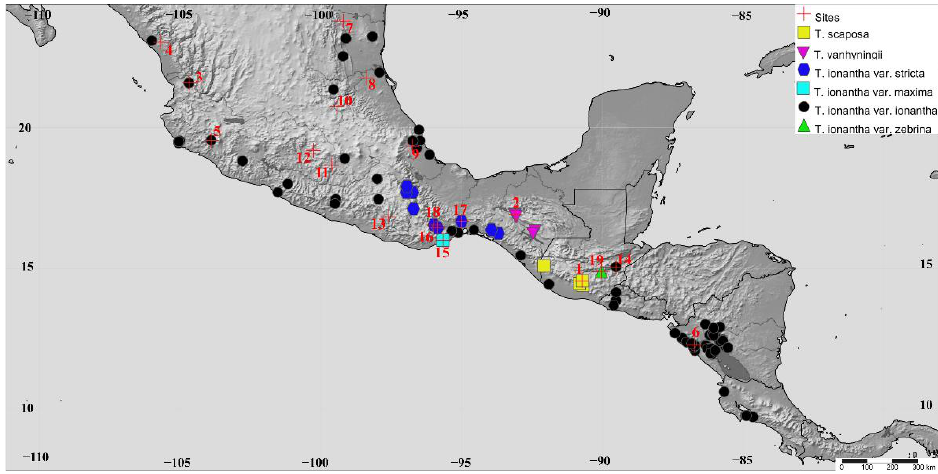
Figure 6. Geographic distribution of the taxa of the T. ionantha complex and populations sampled (numbers 1–19). Populations 1, 2, 16, 18 and 19 represent the type localities of T. scaposa , T. vanhyningii